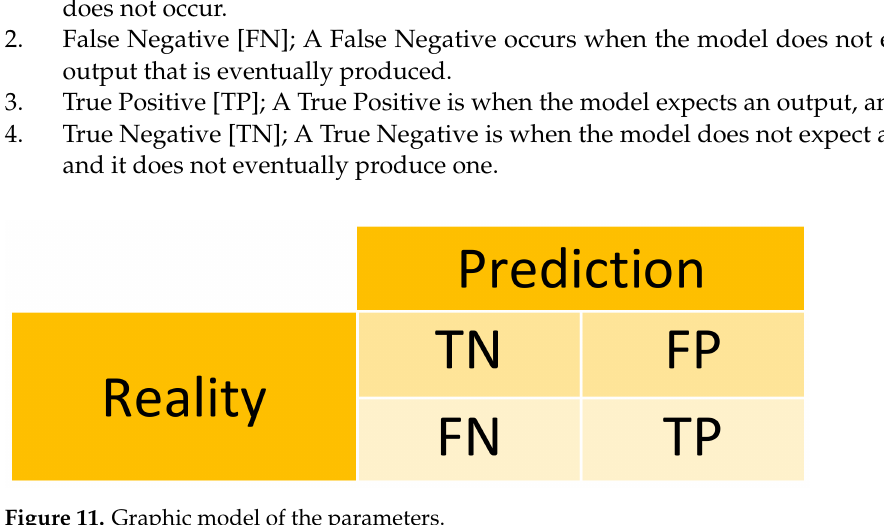
Figure 11. Graphic model of the